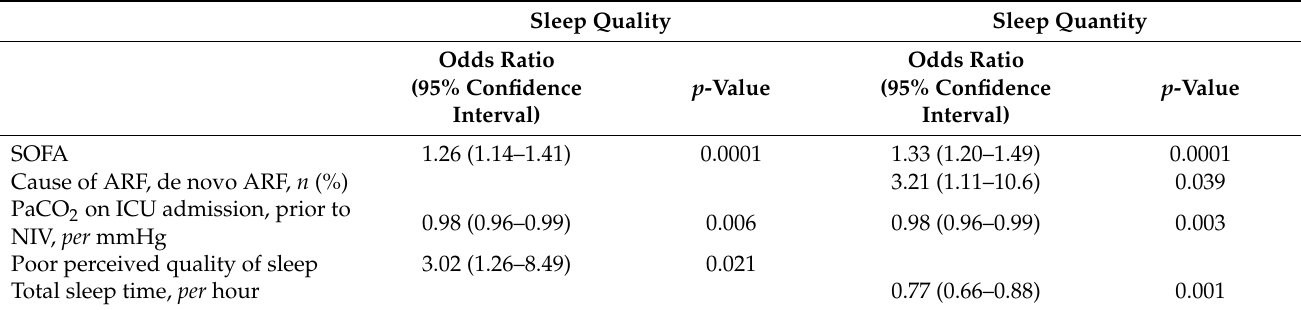
Table 4. Multivariate analysis: factors associated with NIV